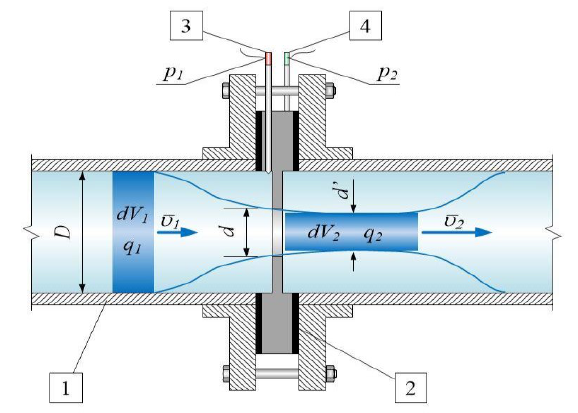
Fig. 1. Fluid flow through a measurement orifice: 1 – pipe, 2 – orifice, 3, 4 – pressure